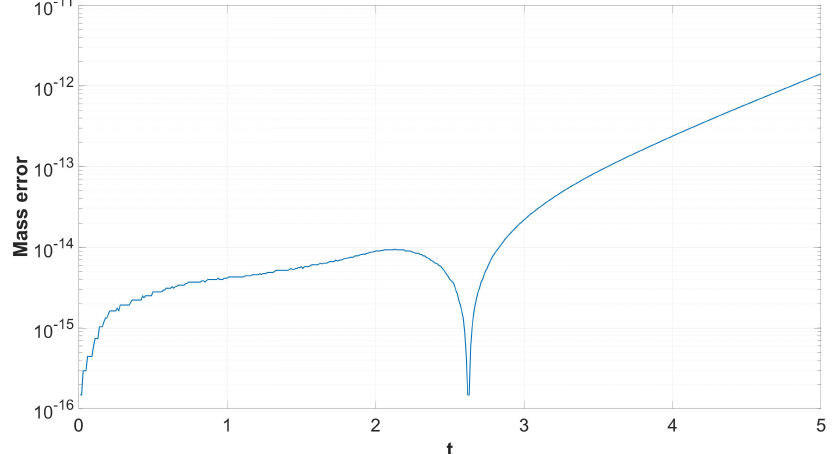
Figure 14. The mass error versus t without the use of finite difference schemes for the spatial semi-discretisation.